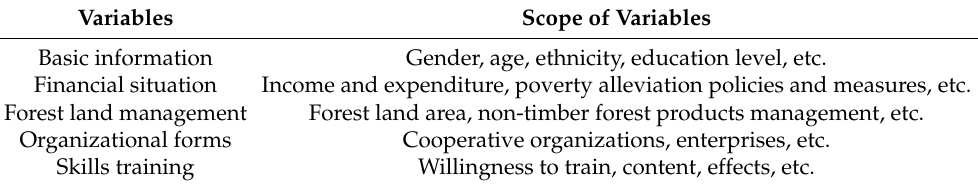
Table 2. The specific questions on the questionnaire.